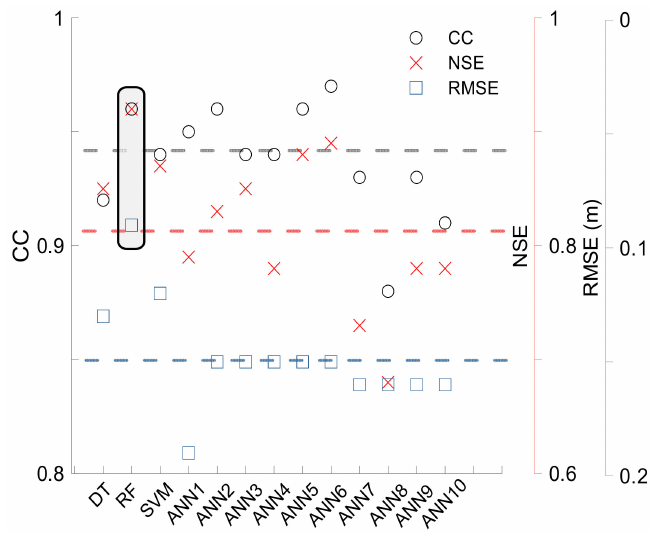
Figure 12. Correlation coe ffi cient (CC), Nash–Sutcli ff e e ffi ciency (NSE), and RMSE values for machine learning models. The dotted lines indicate the average values of each index. The gray rectangles refer to the models showing the best